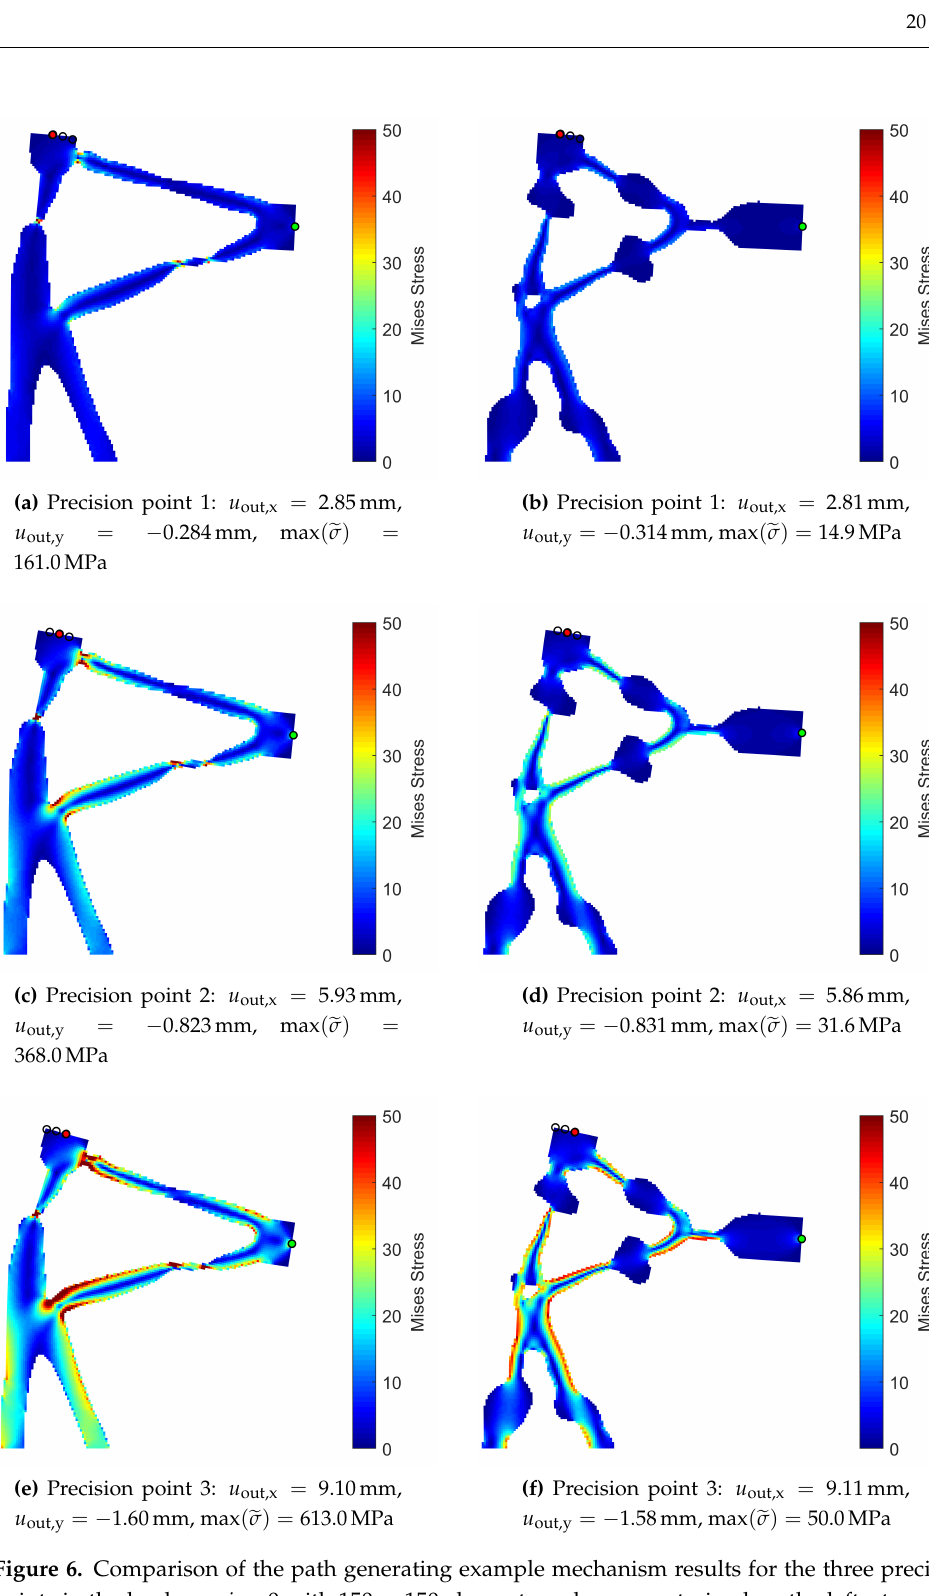
Figure 6. Comparison of the path generating example mechanism results for the three precision points in the load case i = 0 with 150 150 elements, volume constrained on the left, stress and volume constrained on the right)